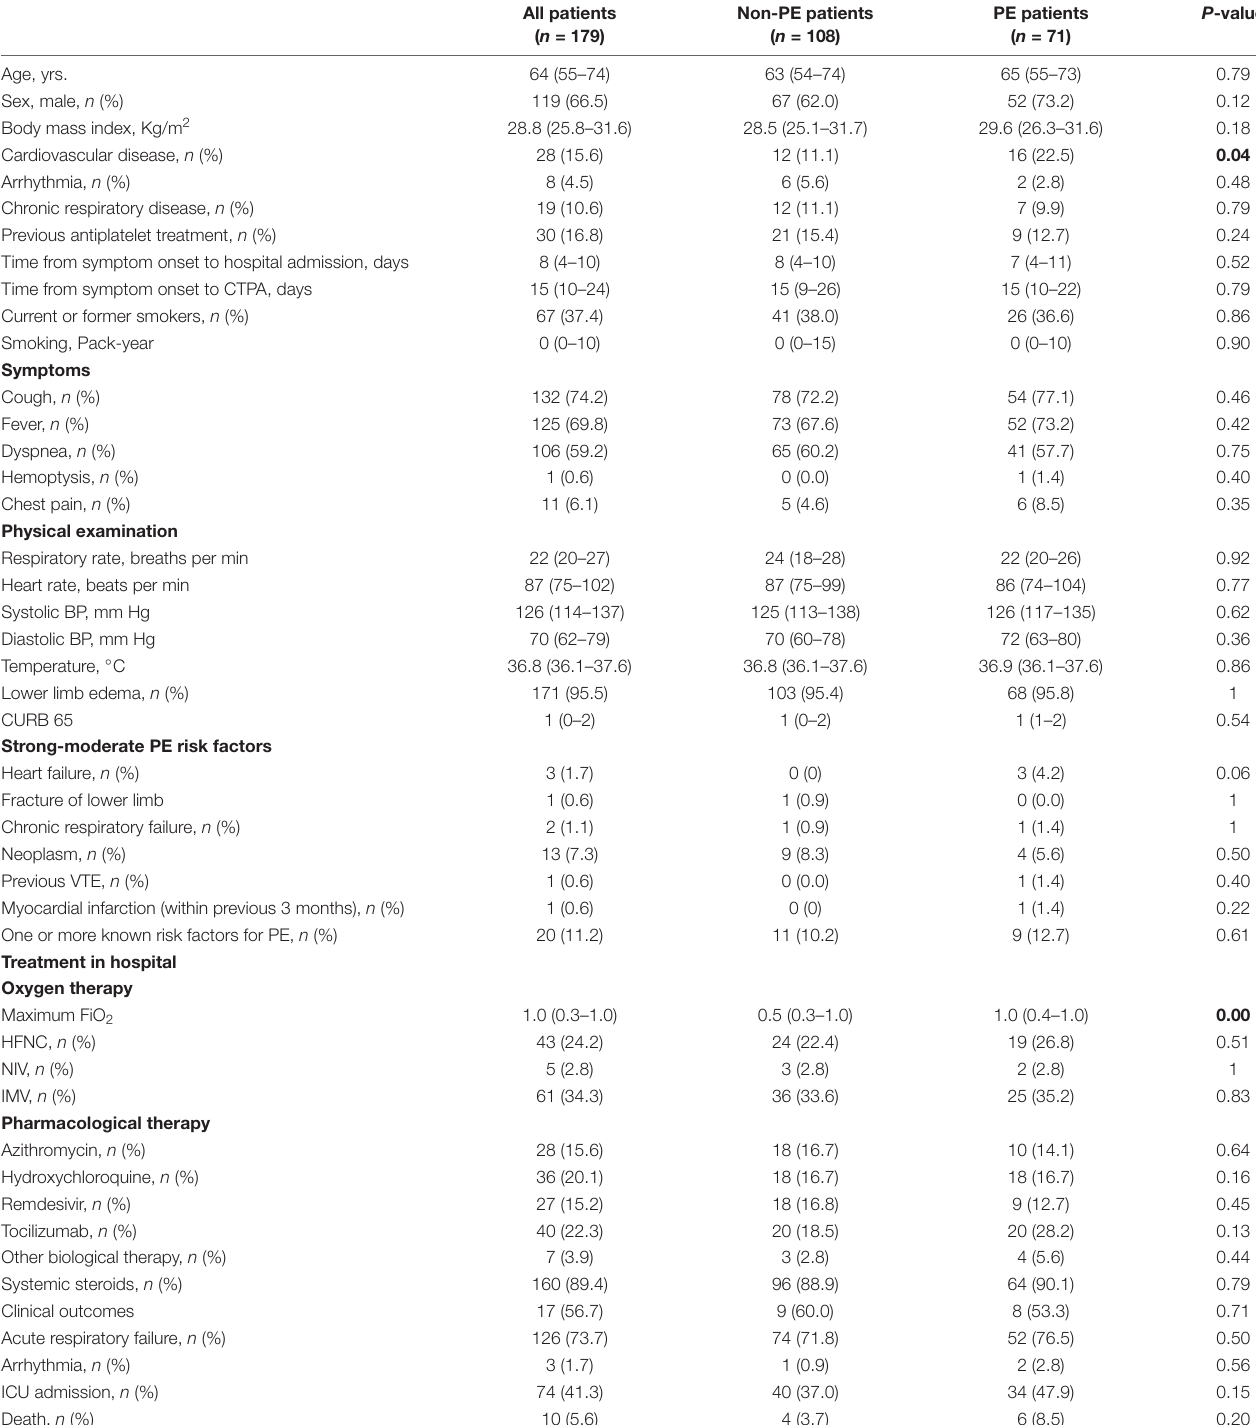
TABLE 1 | Baseline anthropometric and clinical characteristics of patients admitted because of COVID-19 pneumonia (all patients) and according to outcome (with and without pulmonary embolism).